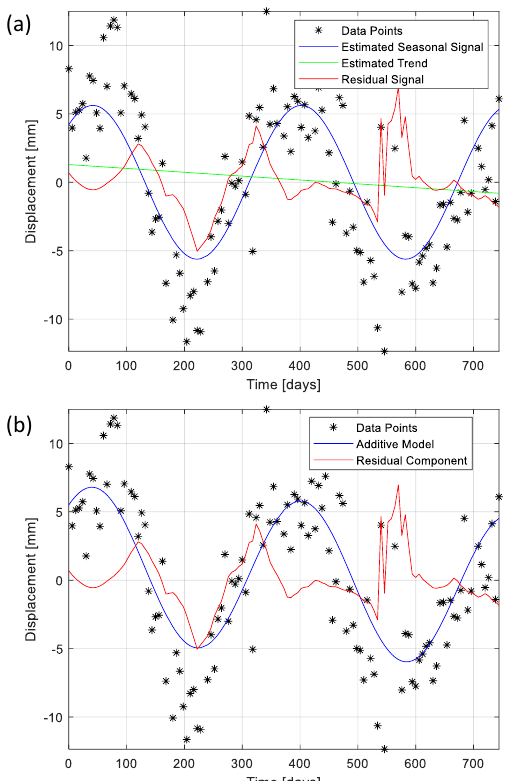
Figure 5. Displacement time series of P1 2 (black) with a quadratic trend (blue) and the residual component (red).